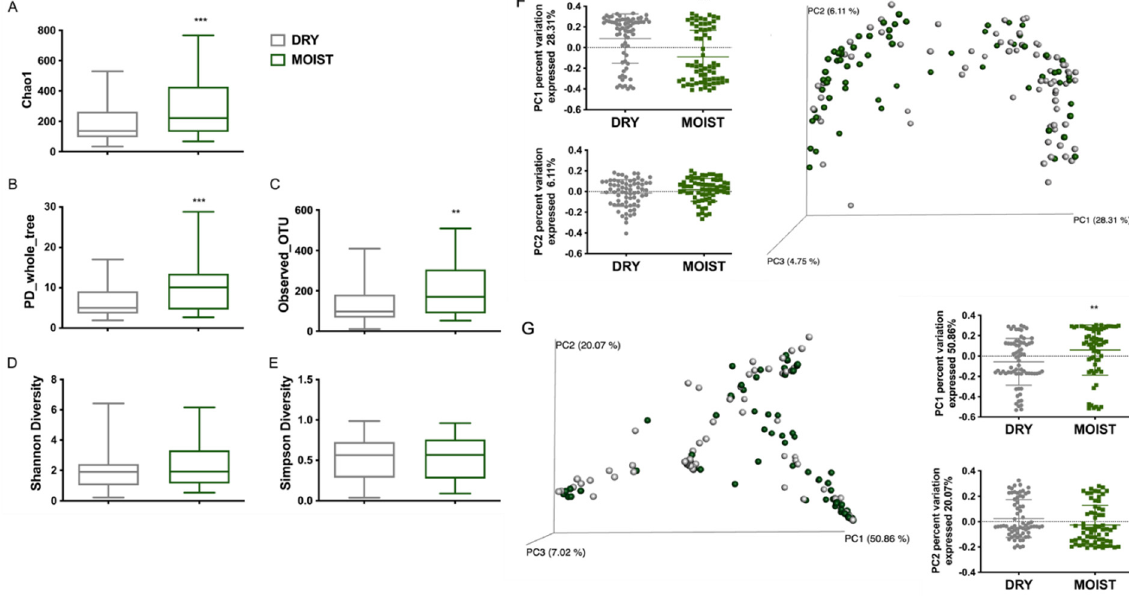
Figure 3. Diversity of the microbiota of dry and moist skin. ( A ) Chao 1. ( B ) PD_whole_tree, comparing alpha diversity. ( C ) observed OTUs. ( D ) Shannon Diversity. ( E ) Simpson Diversity. ( F ) Unweighted PCoA plot and PC1 and PC2 percent variation. ( G ) Weighted PCoA plot and PC1 and PC2 percent variation. ( A – E ) Alpha diversity. ( F – G ) Beta-diversity. Data were analyzed with unpaired parametric t-test with Welch correction compared with dry group. * p < 0.05, ** p < 0.01, *** p < 0.001.